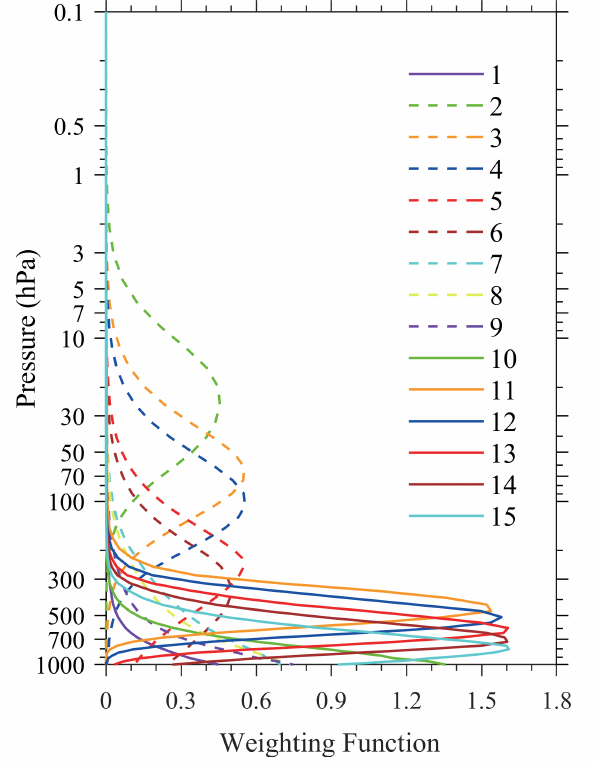
Figure 1. Weighting functions (WFs) for the 15 channels of the MWHS-2 onboard the FY-3E. Fifteen days of FY-3E MWHS-2 observation data covering the period from 24 Septem- ber to 8 October 2021, were employed to calculate the bias and errors. In this study, RTTOV Version 13 and ERA-5 data sets with 6-h intervals (UTC 00, 06, 12, 18) were adopted as the RTM and the background field for simulation,